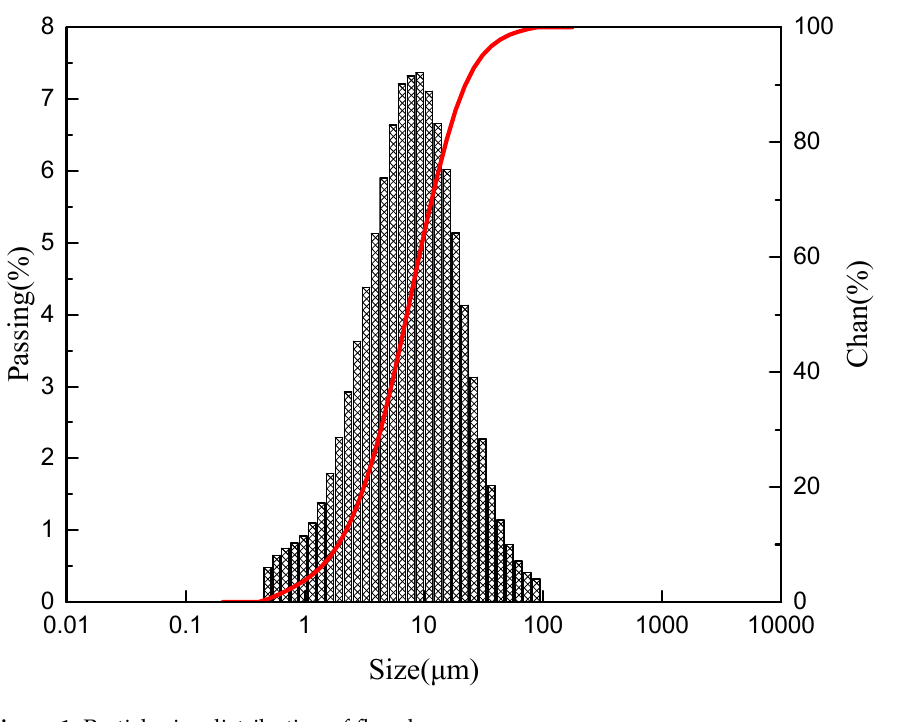
Figure 1. Particle size distribution of fly ash.